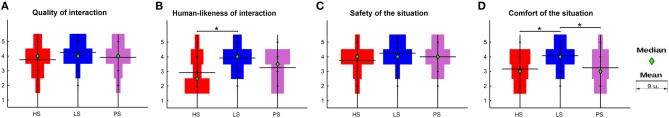
Secondary subjects questionnaire. Discrete violin plot presents the distribution of answers obtained to different questions of the human-prosthesis interaction. Friedman ANOVA test p-values: (A) 0.2956, (B) 0.0366, (C) 0.1353, and (D) 0.0117. Statistical significance between control modalities is expressed by asterisks, where *p ≤ 0.05. A single legend is presented on the right side, where the median is represented by a green diamond and the mean by an horizontal black line (the size of the line of the mean refers to 9 units).